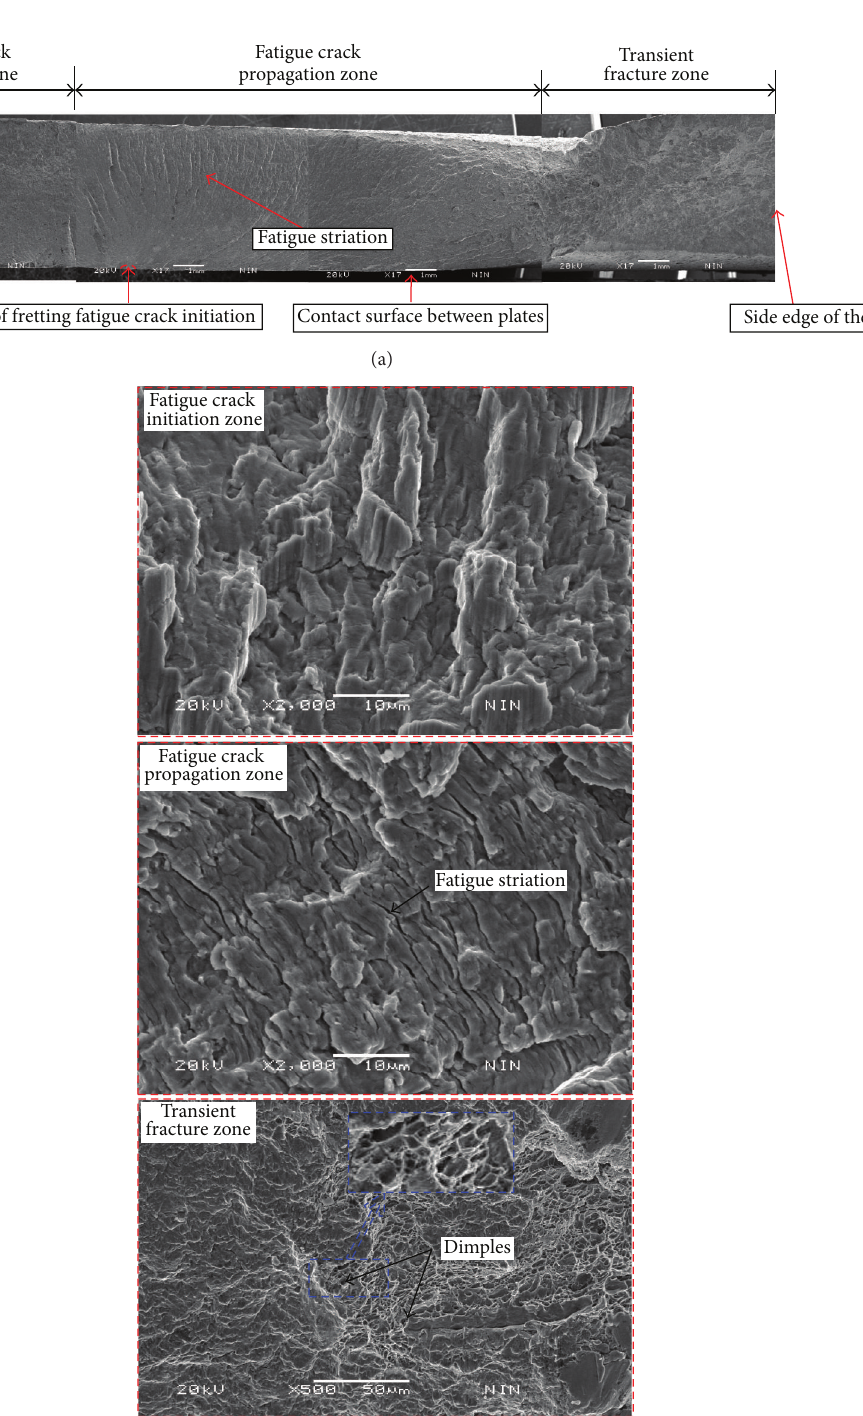
Figure 5: SEM images of a fracture surface (fatigue life = 865471; the left is near the middle of the plate, and the right is close to the side edge); (a) fractured surface (lower magnification); (b) fractured surfaces at crack initiation, crack propagation, and transient fracture zones (higher